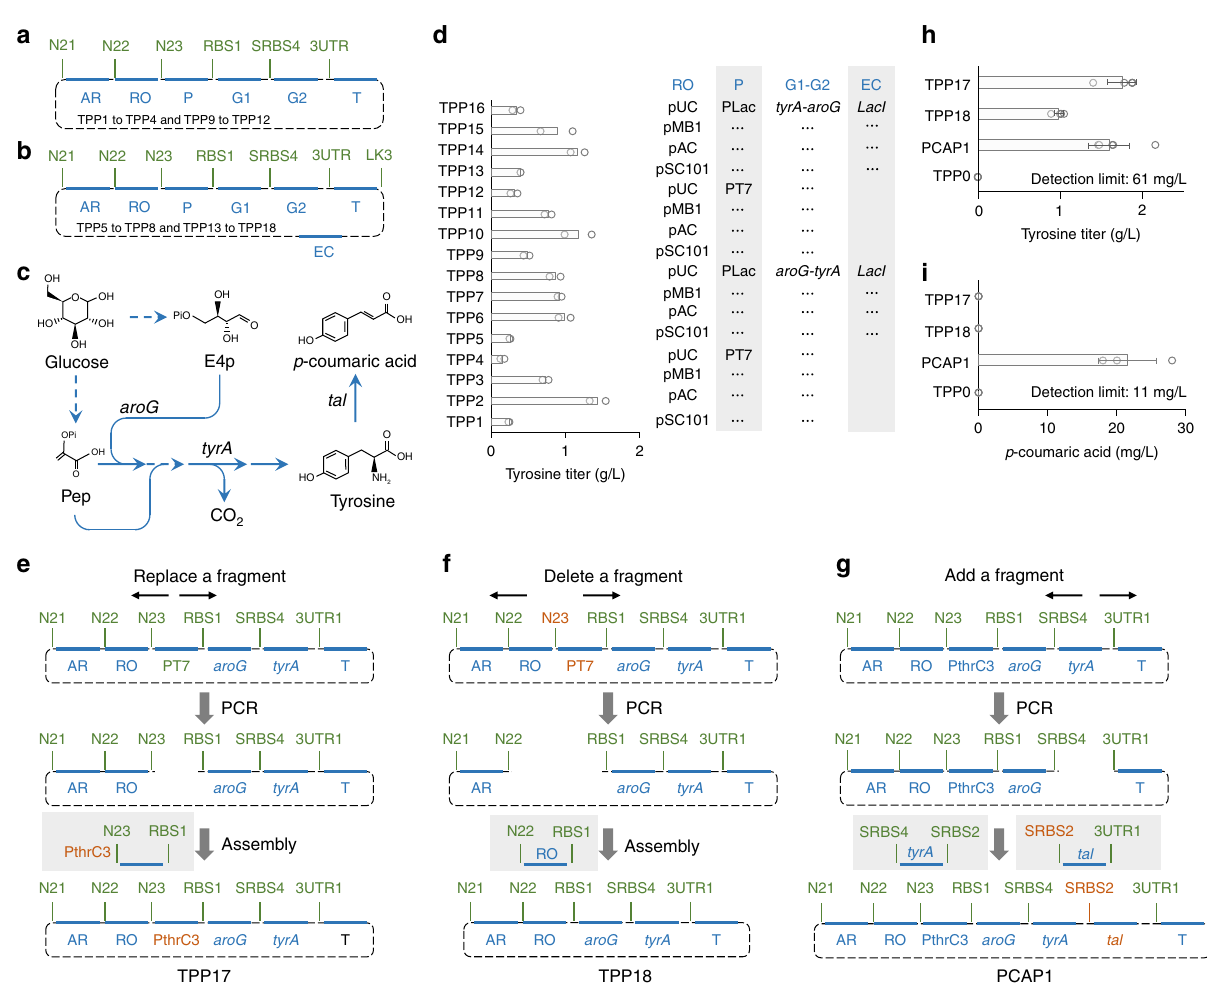
Fig. 6 Constructing and editing plasmids using standard parts under GTS. Structure of the 16 plasmids for improving tyrosine production in E. coli , a Six- or b seven-fragment assembly were performed to construct these 16 plasmids (Supplementary Fig. 8). Blue thick horizontal bars represent fragments; RO: replication origin (pSC101, pAC, pMB1, or pUC); P: promoter (PT7 or PLac); G1, G2: two genes in an operon ( tyrA - aroG or aroG - tyrA ); T: terminator; AR: antibiotic resistance marker (Spec R ); EC: LacI repressor expression cassette. Green texts indicate barcodes; N21, N22, N23, and LK3: